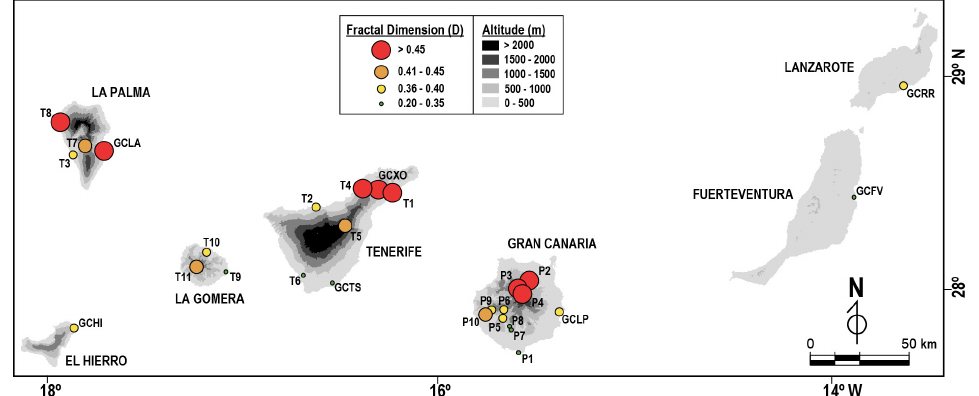
Fig. 9. Spatial variability of rainfall fractal dimension over the